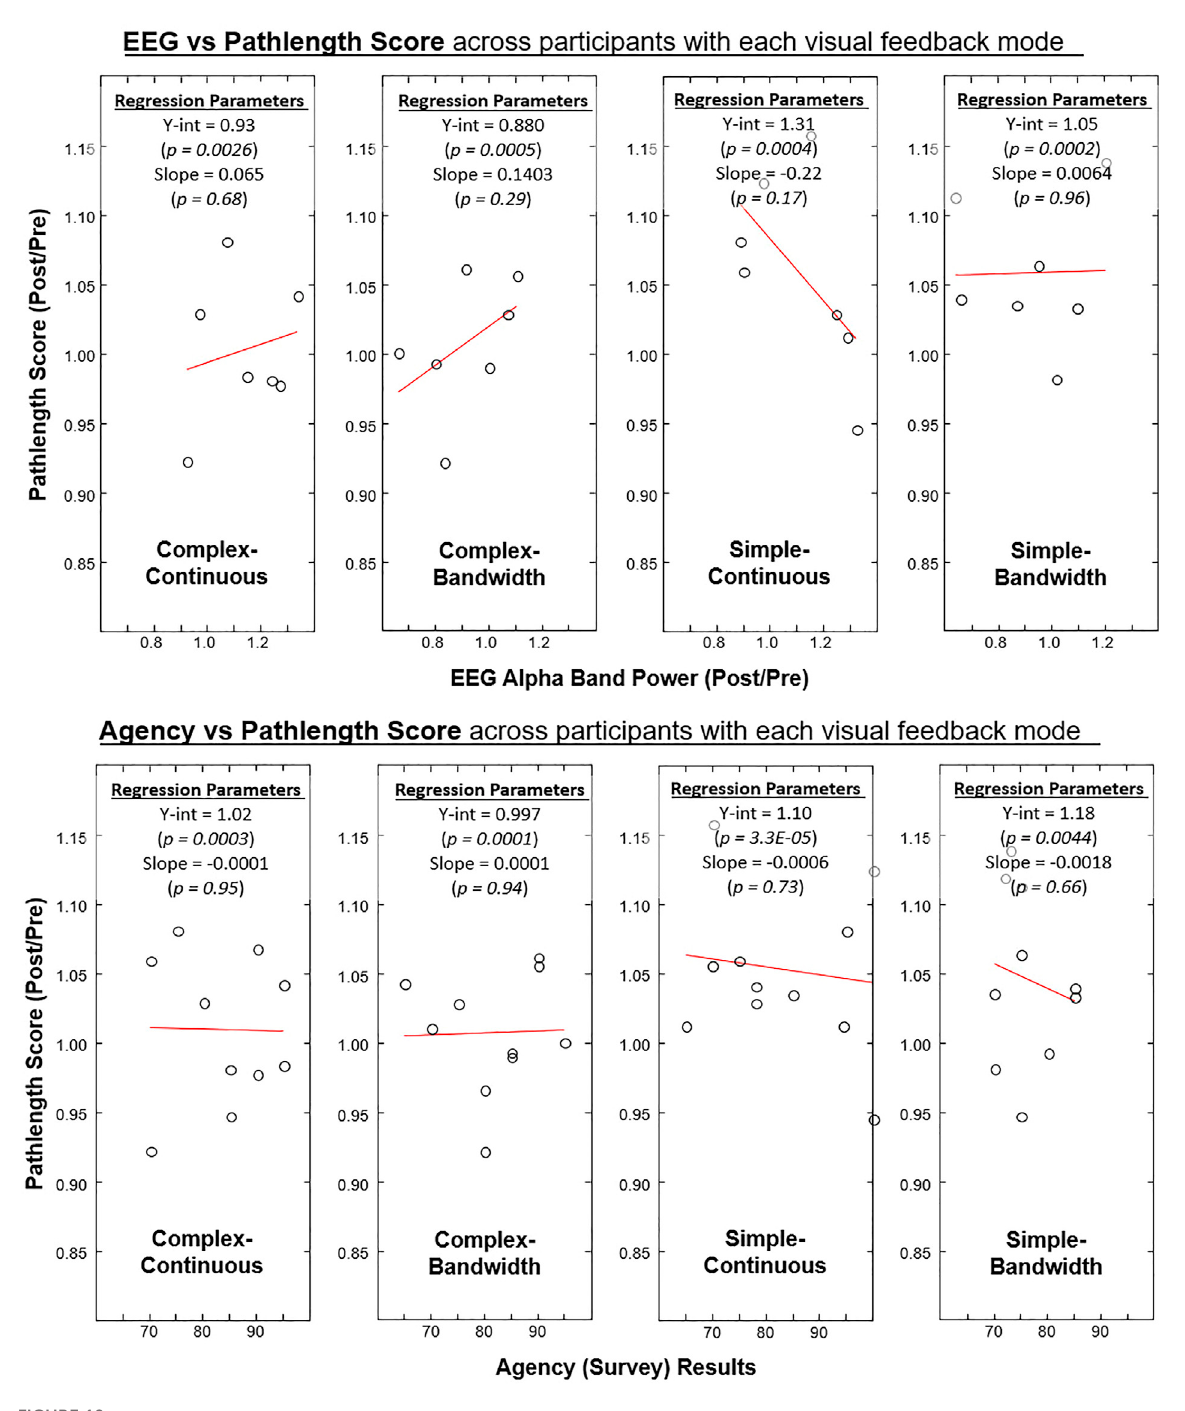
FIGURE 10 EEGandAgencyversusPathlengthScoreperVisualFeedbackMode.TOP)EEGalphabandpowerandpathlengthscorebothpresentedaspost- training/pre-training. BOTTOM) Agency (survey) results and pathlength score (post/pre). Linear regression parameters (y-int, slope) and respective p -values (based on t -test) to indicate signi fi cant difference from zero shown with each